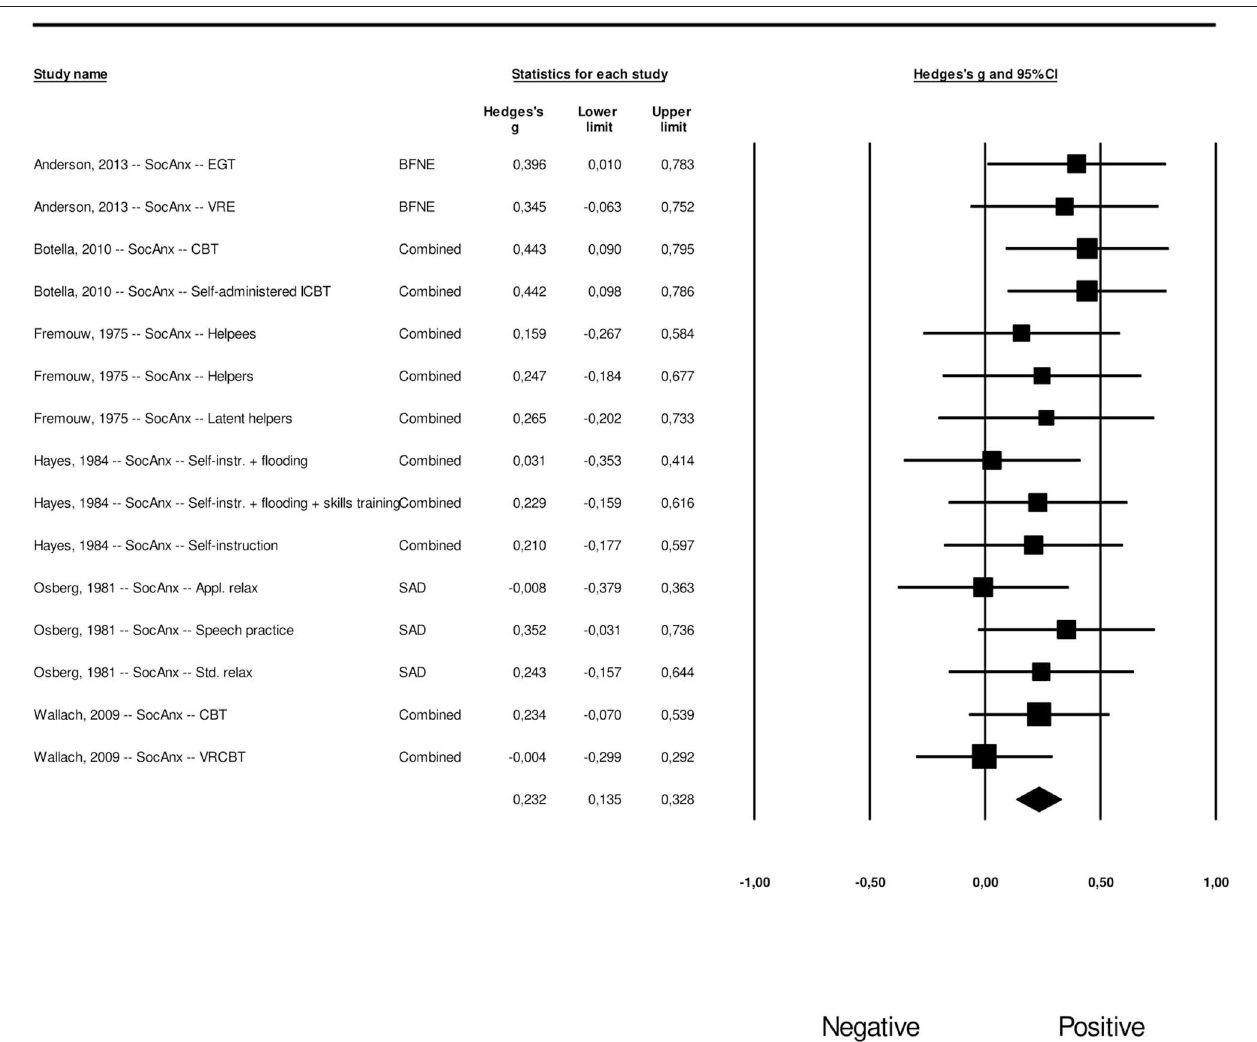
FIGURE 8 | A forest plot of the change in efficacy from post-treatment to follow-up of psychological treatments aimed at fear of public speaking on generalized social anxiety.